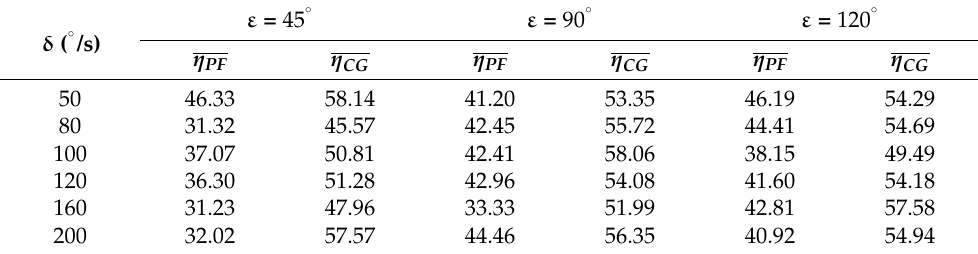
Table 3. Average balance efficiencies η PF and η CG of REF19 under 18 vibration conditions